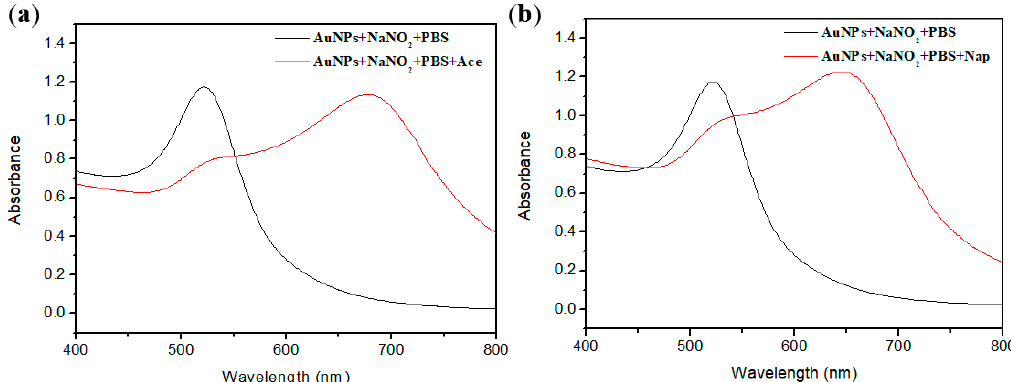
Figure 1. UV-vis absorption spectra before and after adding the target analyte: ( a ) Ace and ( b ) Nap. TEM can be used to observe the dispersion and aggregation of AuNPs. Figure 2a shows that the functionalized AuNPs were well dispersed and spherical with a particle size of approximately 15 nm. Adding the appropriate PBS buffer solution did not change their morphology significantly (Figure 2b). When the analyte was added to the detection solution consisting of AuNPs, NaNO 2 , and PBS buffer, the AuNPs aggregated, as shown in Figure 2c,d. The size distribution of the functionalized AuNPs (AuNPs + NaNO 2 + PBS buffer) without the analyte is shown in Figure 2e, and the average particle size was approximately 15.78 nm. After adding the analyte to the functionalized AuNPs, the AuNPs aggregated with an average particle size of 19~20 nm, as shown in Figure 2f,g.